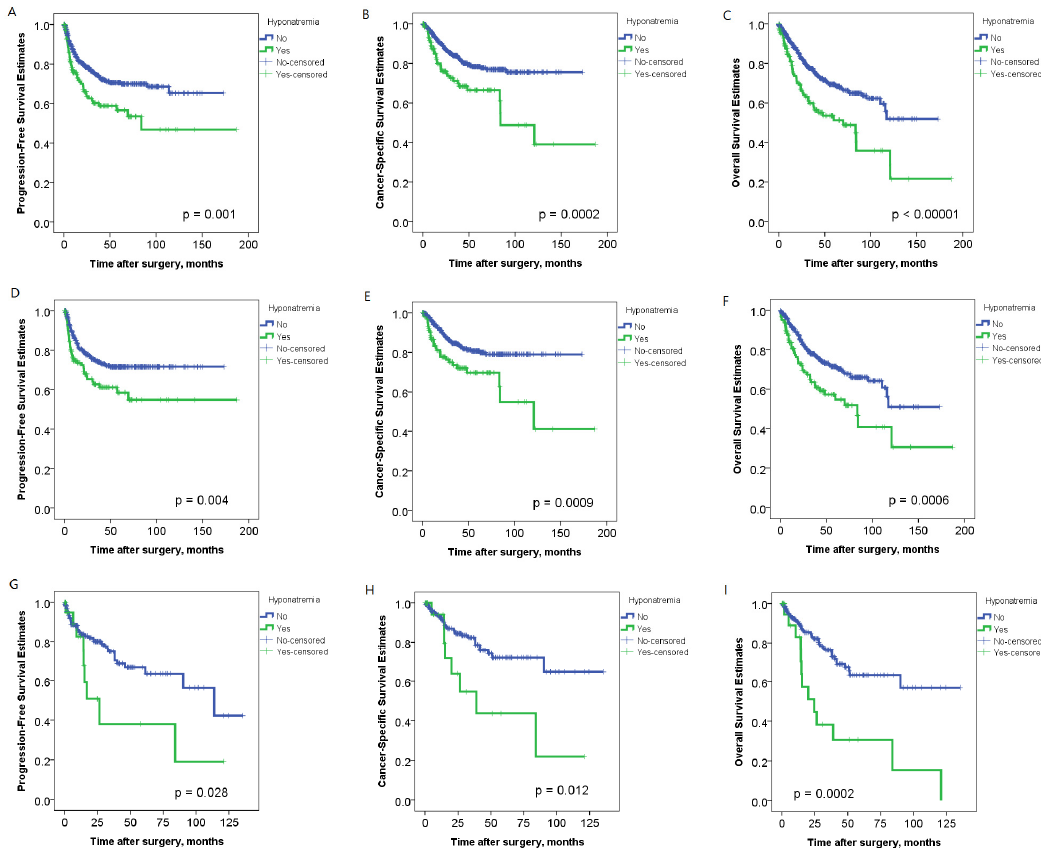
Figure 1. In Kaplan–Meier analysis, hyponatremia was significantly associated with lower progression-free survival (PFS), cancer-specific survival (CSS) and overall survival (OS) in the whole cohort of 737 patients with UTUC ( A–C ), and in patients with UTUC either from Taiwan ( D–F ) or the U.S. ( G–I ).